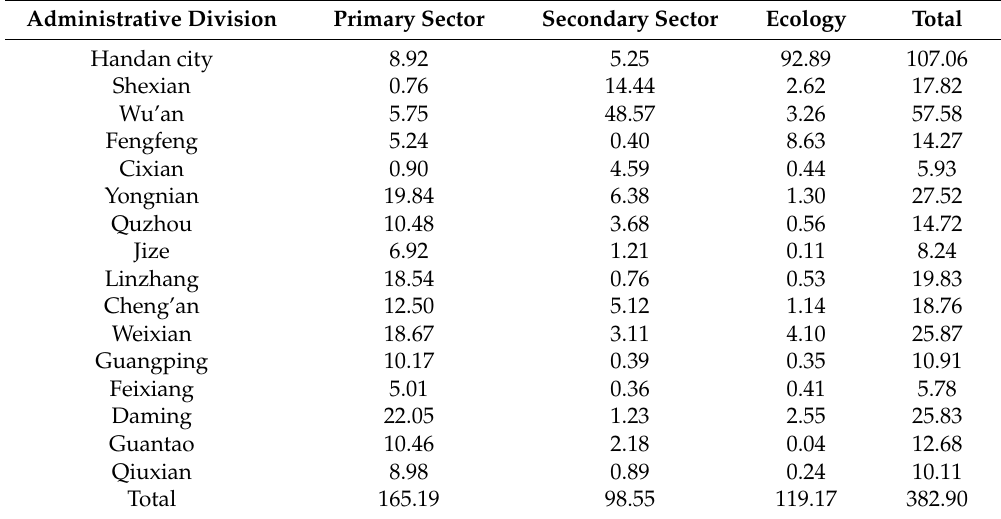
Table 11. Results for recycled water allocated to every user (10 6 m 3